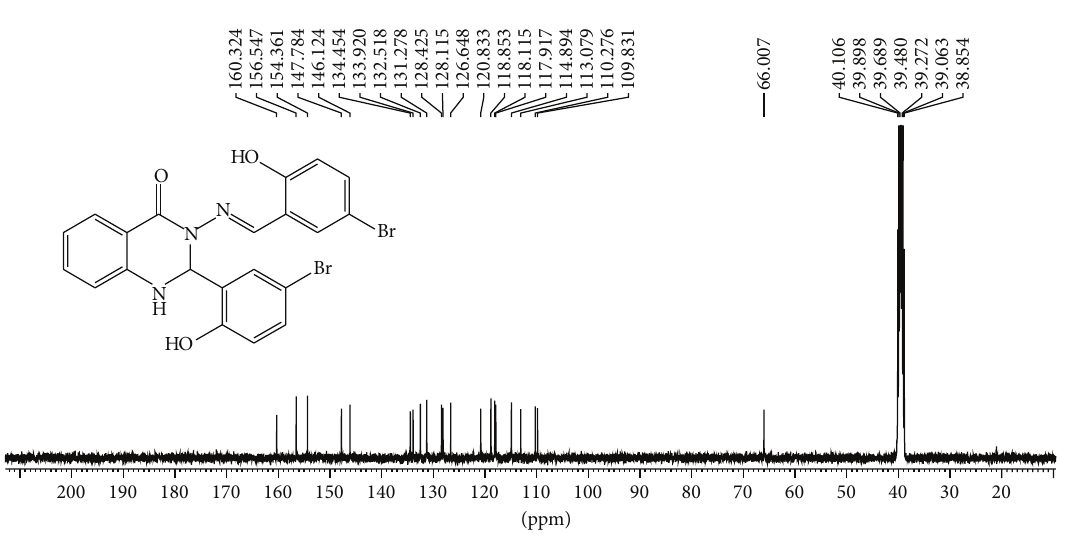
Figure 6: 13 C NMR spectrum of compound (1) in (100 MHz, DMSO- d6